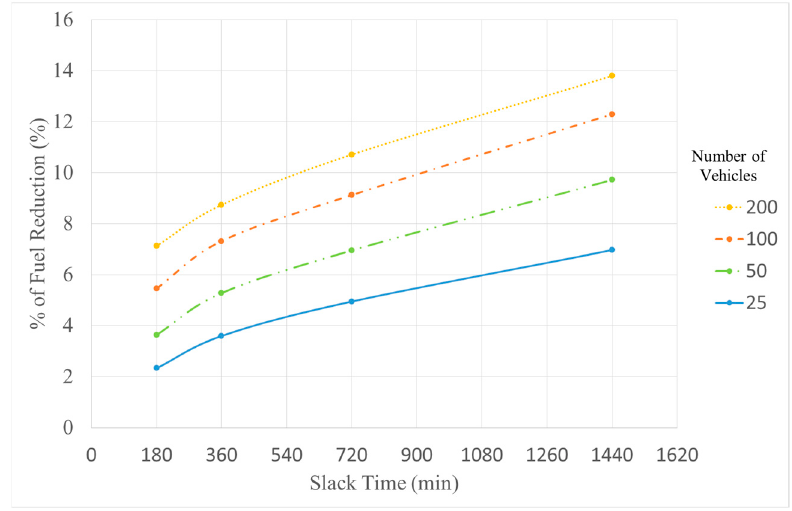
Figure 3. Percentage of fuel reduction for different numbers of vehicles and slack times.